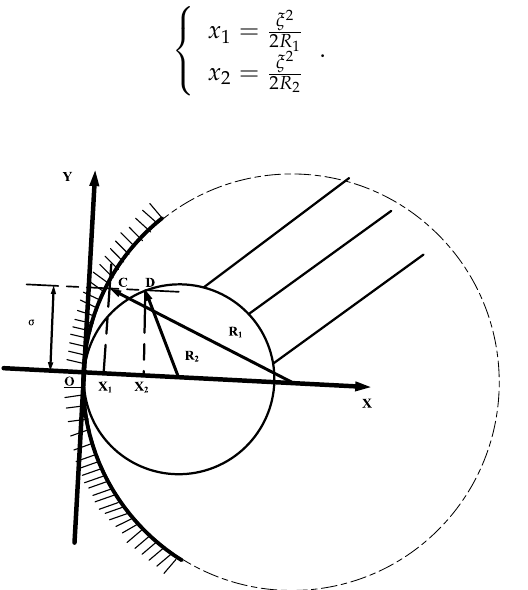
Figure 2. Transient collision of docking connectors with an elastic pin head engaging with an elastic inner-wall of a chamfered hole.